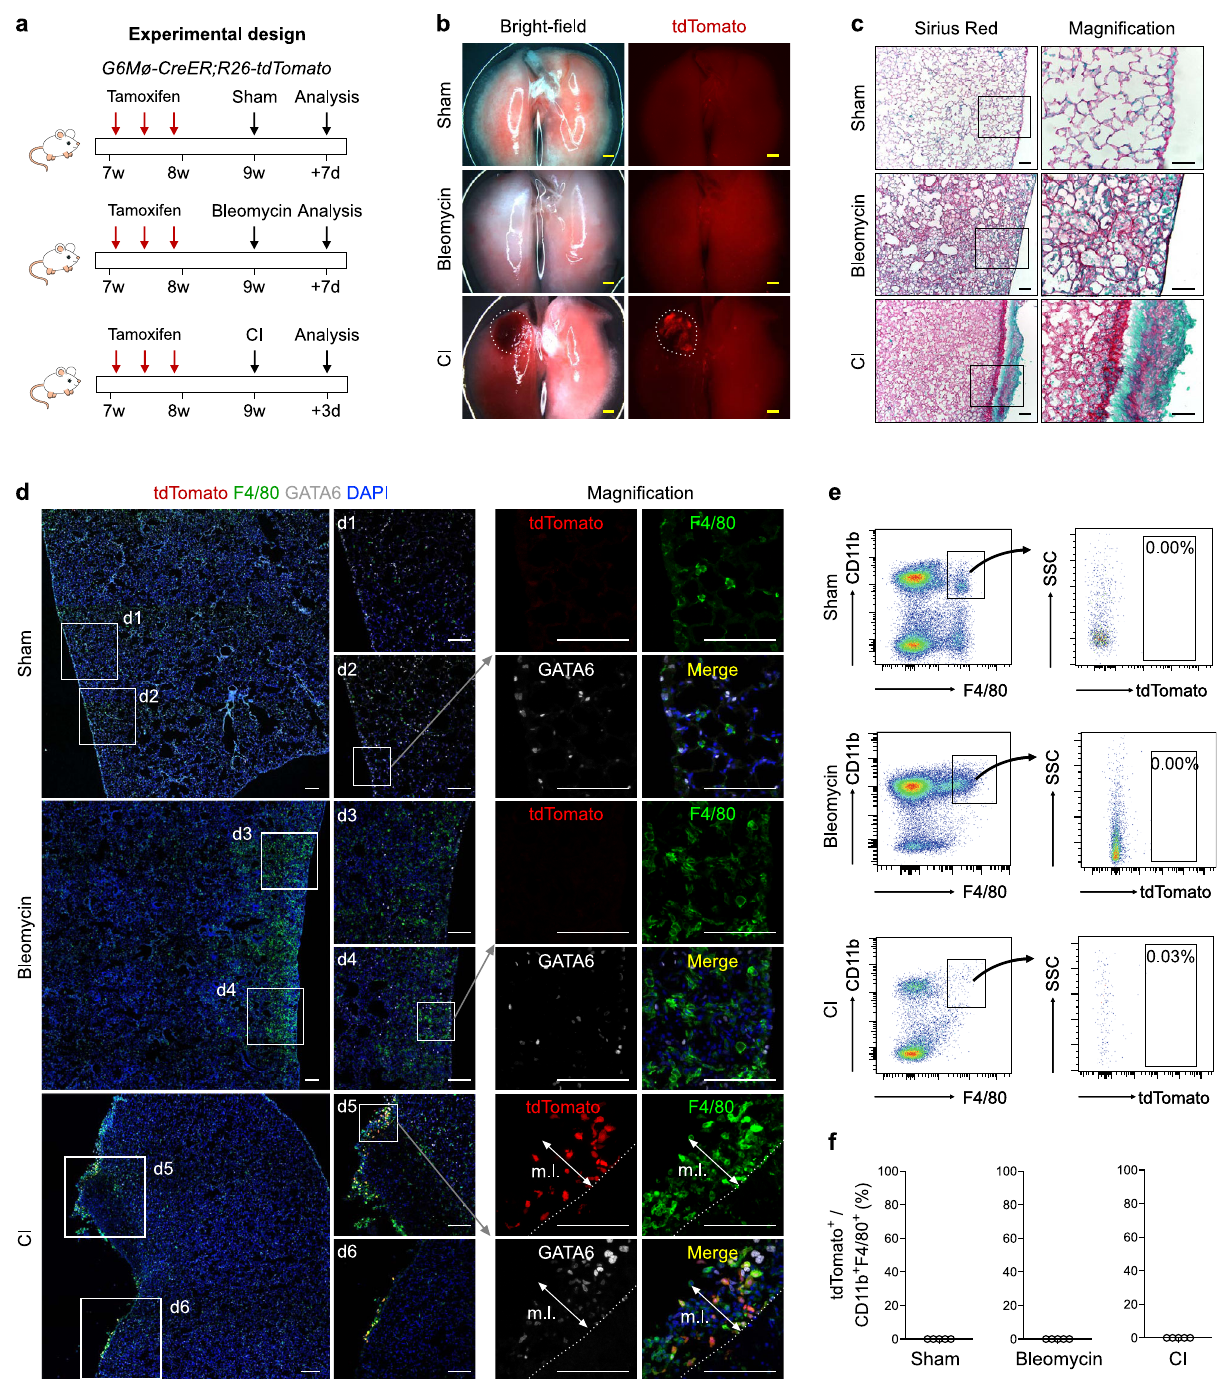
Fig. 3 Pleural macrophages do not invade deep into the lung parenchyma after bleomycin treatment or CI. a Schematic fi gure showing experimental strategies. CI cryoinjury. b Whole-mount bright- fi eld and fl uorescent images of lungs after different injuries. Dotted line, CI region. Scale bars, 1 mm. c Sirius red staining of lung tissue sections after bleomycin or cryoinjury in lungs. Boxed regions are magni fi ed. Scale bars, 100 µ m. d Immunostaining for tdTomato, GATA6, and F4/80 on injured regions of lungs. m.l., mesothelial layer. Boxed regions are magni fi ed. Scale bars, 100 µ m. e , f FACS and quanti fi cation analysis of the percentage of macrophages expressing tdTomato from injury regions of the lung. Data are the mean ± SD; n = 5 mice per group. Each image is representative of fi ve individual biological samples ( b – d ). Source data are provided as a Source Data fi